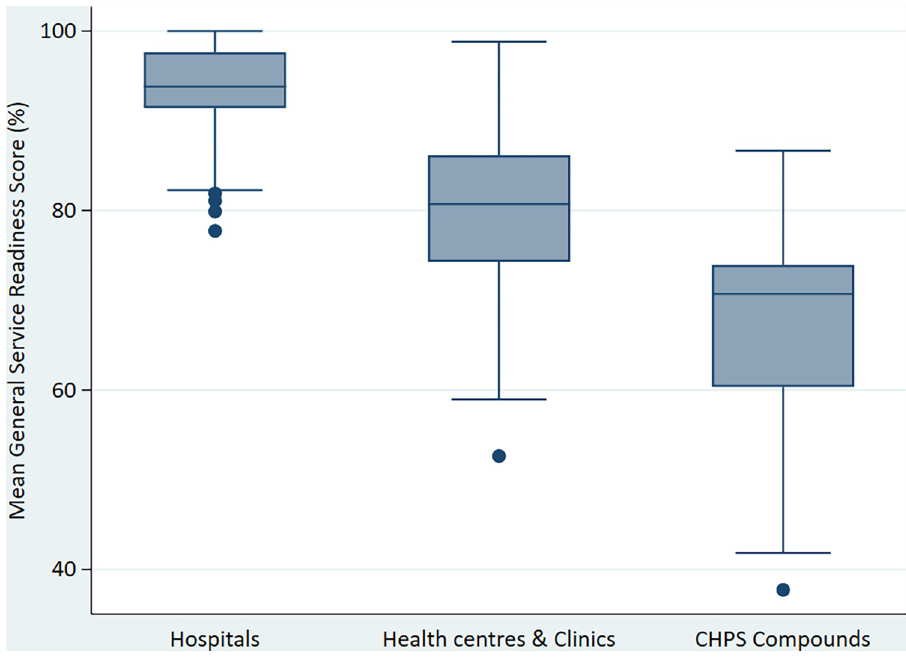
Fig 1. Boxplot of general service readiness score by facility